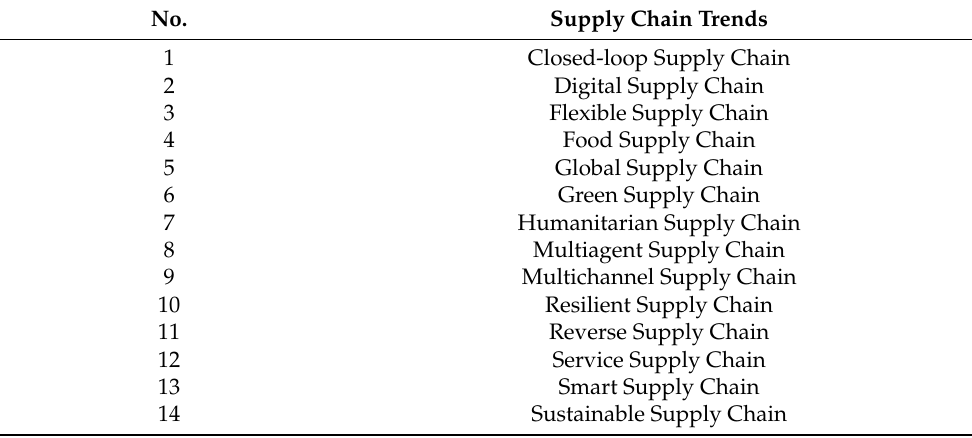
Table 2. Identified global theoretical supply chain trends, alphabetical order; own elaboration based on the conducted